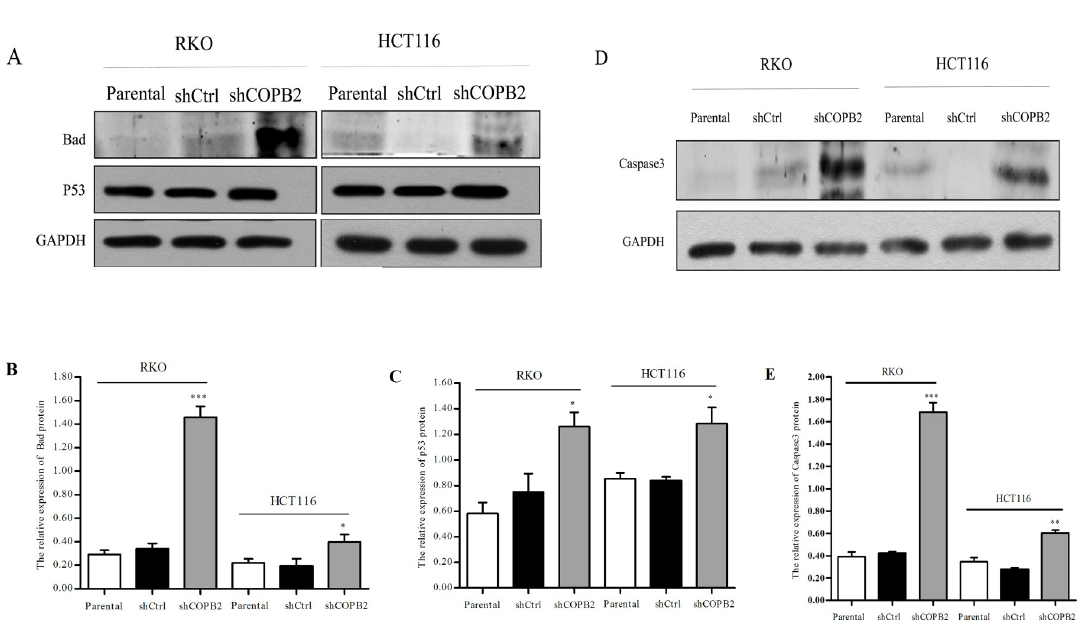
Fig 8. Western blot analysis of the expression levels of JNK/c-Jun signaling pathway related proteins in RKO and HCT116 cells. ( A-E ) COPB2 knockdown increased the protein expression levels of Bad, p53, and Caspase 3. � P < 0.05, �� P < 0.01, or ��� P < 0.001 compared with shCtrl and parental